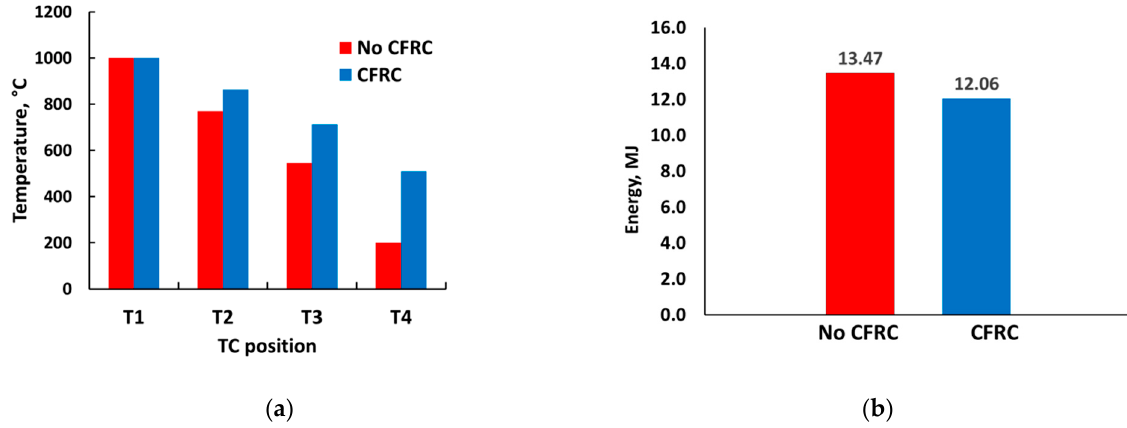
Figure 9. ( a ) Temperature at 1200 s (dwell segment) measured by thermocouples in different locations and ( b ) total energy consumed with different setups.